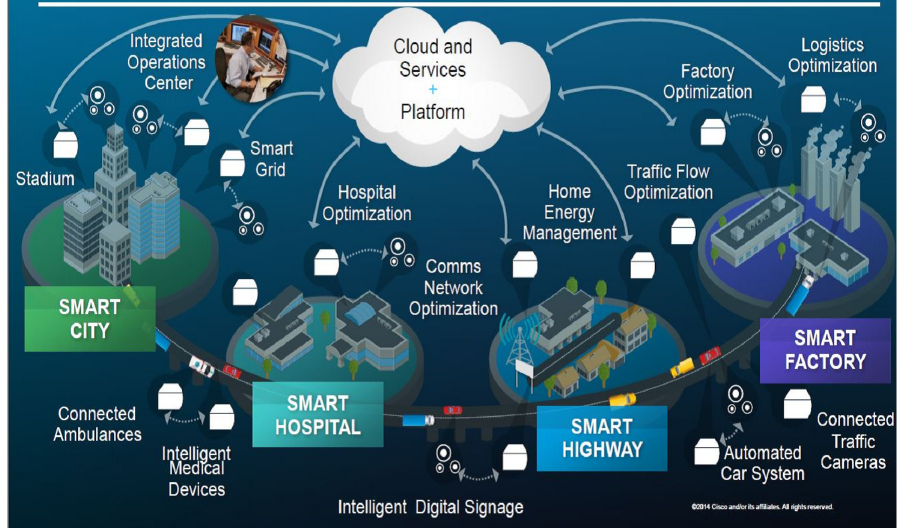
Figure 13. Major components of smart city.